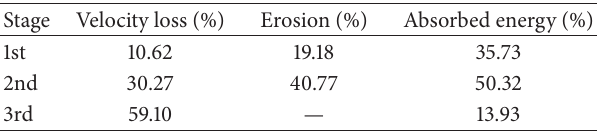
Table 4: Fraction of loss of velocity, mass and energy of the projectile in the three stages (adapted from previous work [2]).